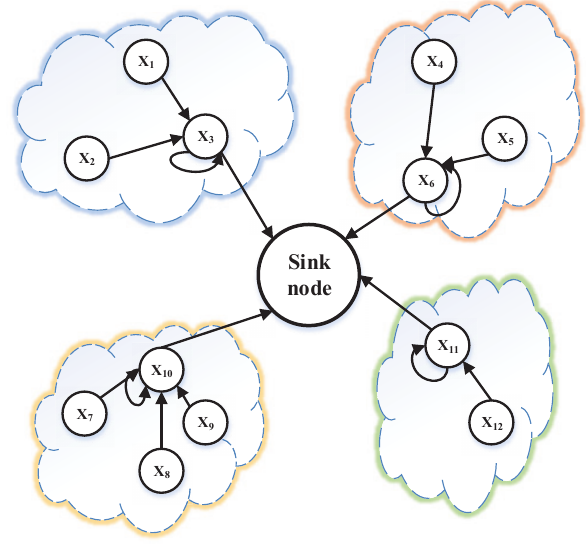
Figure 3. Diagrammatic sketch of our model.